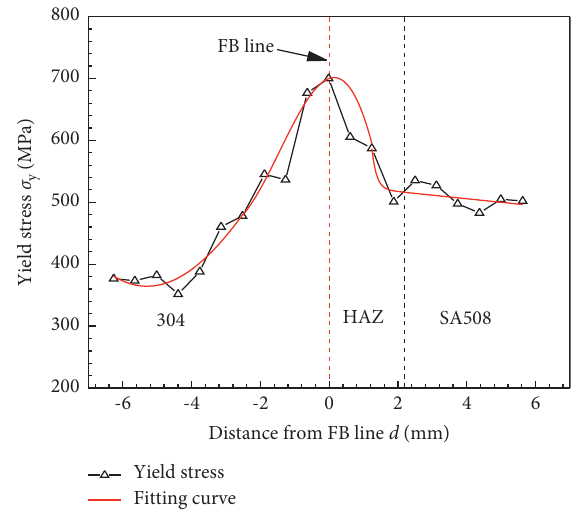
Figure 4: Local yield strength σ y distribution of welded joints at different positions from the FB